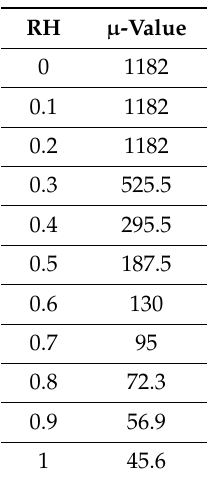
Table A18. Water vapor di ff usion resistance factor—Design.